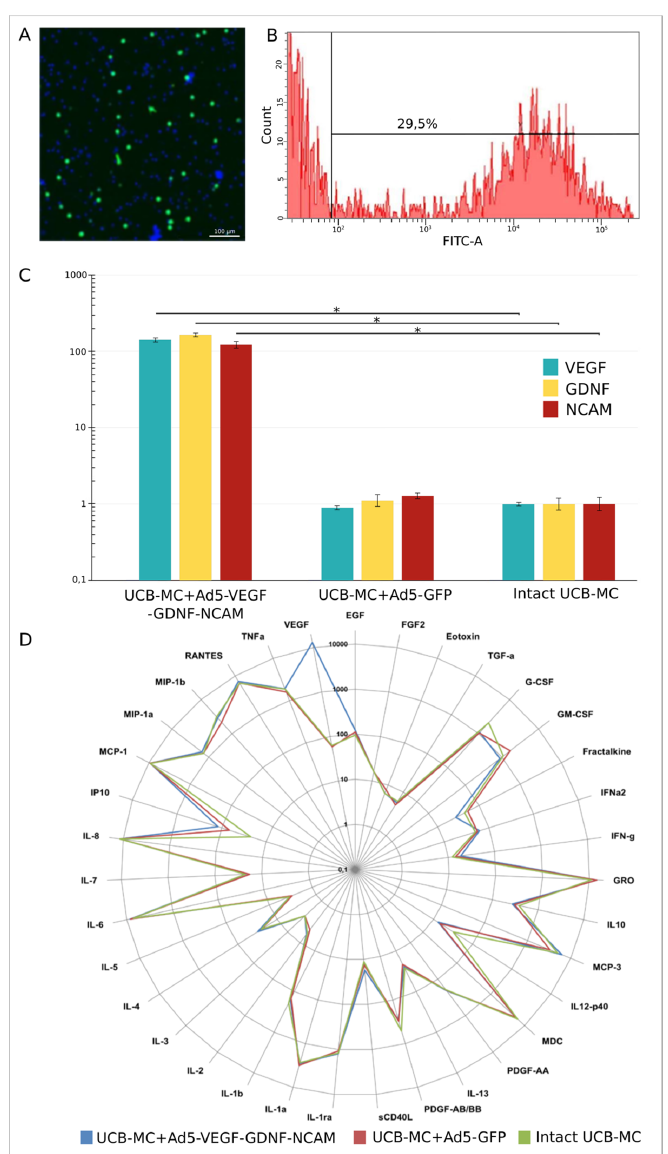
Figure 1. Molecular analysis of gene modified umbilical cord blood mononuclear cells (UCB-MC). ( A , B )—Production of green fluorescent protein (GFP) in UCB-MC, 72 h after transduction with Ad5-GFP (MOI = 10). ( A )—fluorescent microscopy shows a specific green glow in UCB-MC+Ad5-GFP. Cell nuclei are stained with Hoechst 33342 (blue glow). Scale bar = 200 µm. ( B )—flow cytometry analysis demonstrates that 29.5% of UCB-MC e ff ectively produce reporter GFP. ( C )—Quantitative analysis of mRNA vegf165 , gdnf , and ncam1 levels in intact (naïve) UCB-MC and genetically-modified UCB-MC, 72 h after transduction with three adenoviral vectors simultaneously carrying the therapeutic genes (Ad5-VEGF, Ad5-GDNF, and Ad5-NCAM) or with Ad5-GFP (UCBC + Ad5-GFP), with a MOI = 10. Data from two independent experiments are represented as an average value of ± SE, *— p < 0.05. ( D )—Radial comparative diagram of cytokine, chemokines and growth factors in supernatant obtained 72 h after incubation of gene modified UCB-MC (UCB-MC + Ad5- vascular endothelial growth factor (VEGF)- glial cell-derived neurotrophic factor (GDNF)- neural cell adhesion molecule (NCAM) and UCB-MC + Ad5-GFP) and intact